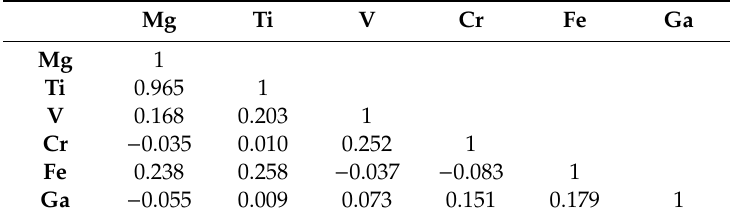
Table 6. Correlation table for trace elements of rubies from Mogok, Myanmar.